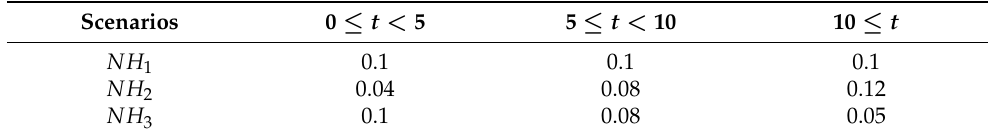
Table 1. Hazard functions of scenarios under null hypothesis.